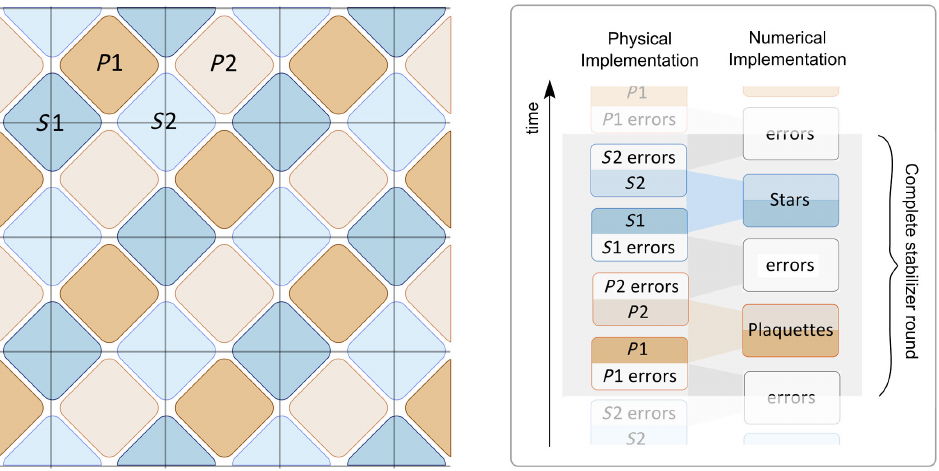
FIG. 7. Scheduling stabilizer measurements. Stabilizer measurements are split into four rounds, two of each type, plaquettes (orange) and stars (blue). The underlying lattice and qubit structure is shown here in black for a planar code of lattice dimension L ¼ 4 . Decomposition of the stabilizer measurement procedure allows each round to be described as a round of perfect measurements either followed or preceded by errors. The stabilizer implementation including these errors is shown on the